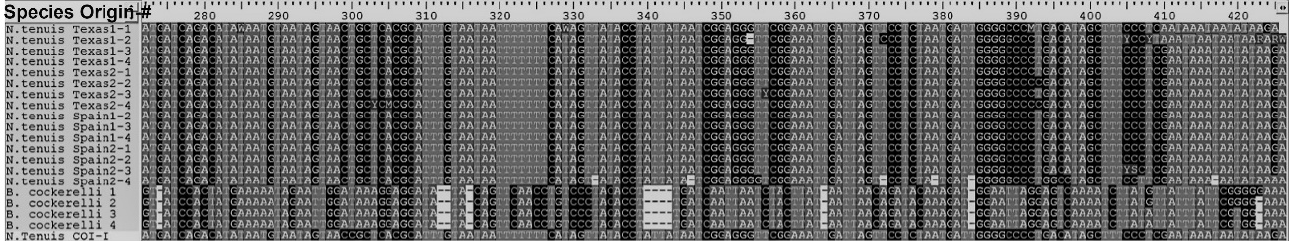
Figure 4. Mean (±SE) population of Nesidiocoris tenuis on tomato plants in a commercial field located at Pharr, Hidalgo Co. Texas. The moving mean curves shown with lines were fitted by a distance- weighted least squares method. 3.3. Expansion Phase of N. tenuis Our first detection of the N. tenuis in a commercial tomato field occurred during the fall of 2013 in Pharr, TX. This was 15 km from the first point of N. tenuis detection on the experimental field. Nesidiocoris tenuis populations were high during the first weeks of No- vember while tomatoes were flowering and the weather was still warm. Then, the popu- lations decreased as temperatures decreased (Figures 4 and 5). In the organic commercial farm in 2013, there was total yield loss due to a great abundance of N. tenuis reaching over 25 ± 1.4 specimens per plant. As tomato is not planted in the Rio Grande Valley from May to September, N. tenuis was found in a greenhouse in San Benito, TX. However, in this case, N. tenuis was not associated with a yield reduction; instead, it may have contributed to the control of whiteflies. In the commercial fields, the incidence of N. tenuis covered 363 km 2 in the fall seasons of 2013–2014. We detected a rapid geospatial dispersion of N. tenuis on commercial tomato fields in South Texas.